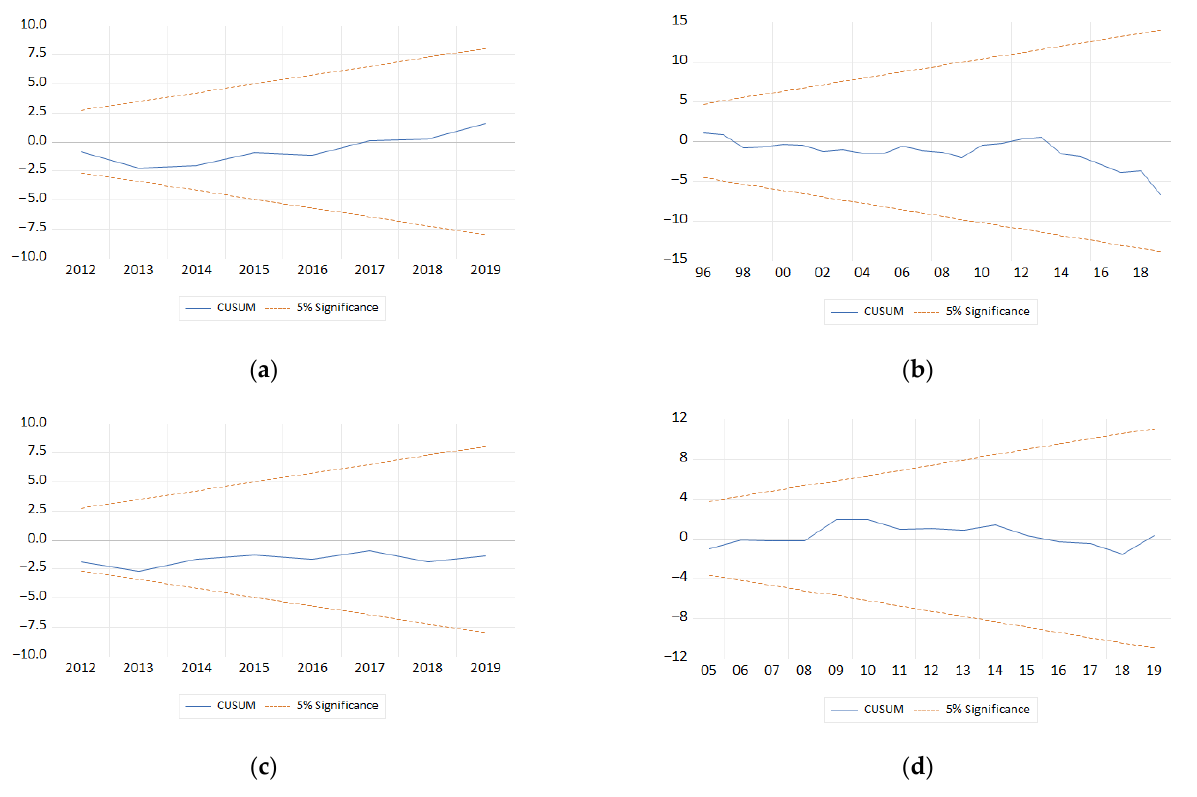
Figure A3. Poland ( a ) Model 1 (dep. variable CO 2 ). ( b ) Model 2 (dep. variable E). ( c ) Model 3 (dep. variable GDP). ( d ) Model 4 (dep. variable FRT).